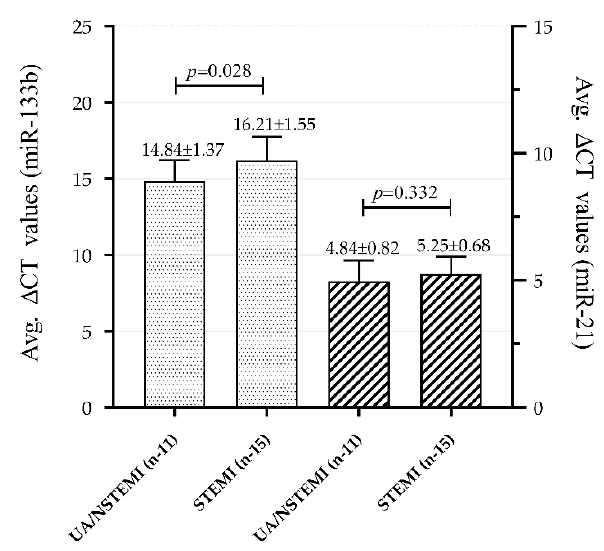
Figure 4. Mean expression values (delta-CT values) of miR-133b (left two bars) and miR-21 (right two bars) in subcategories of ACS in CAD patients. MiR-133b could significantly ( p value = 0.028) differentiate UA/NSTEMI (14.84 ± 1.37; n = 11) category subjects from STEMI (16.21 ± 1.55; n = 15) subjects. MiR-21 could not show a significant ( p = 0.332) difference between UA/NSTEMI (4.84 ± 0.82; n = 11) and STEMI (5.25 ± 0.68; n = 15) subjects. Data are means ± SD. Two-tailed Student‘s t -test was applied for comparison between the groups. p value < 0.05 is considered to be significant.